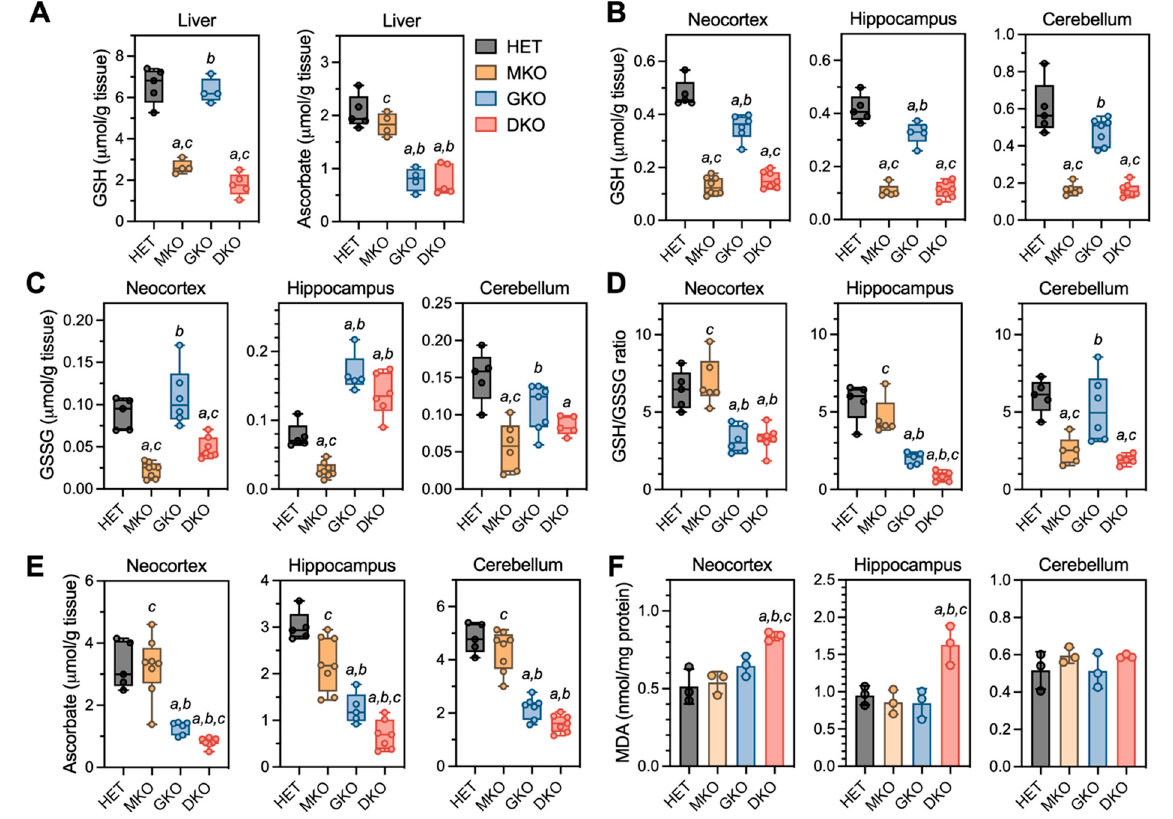
Figure 3. Redox biochemistry in liver and brain regions of young HET, MKO, GKO and DKO mice at PND18. ( A ), Liver tissues were processed for measurements of GSH and AA. Three brain regions were processed for measurements of ( B ), reduced GSH; ( C ), GSSG (oxidized GSH); ( D ), GSH/GSSG ratios (calculated from GSH and GSSG values of each individual animal); ( E ), AA; and ( F ), MDA (malondialdehyde is one of the final products of intracellular polyunsaturated fatty acids peroxidation). Data are expressed as means ± S.D. ( N = 4–5/genotype for livers and N = 5–8/genotype/region for brains). Group differences were analyzed by one-way ANOVA followed by Bonferroni post-hoc test. a p < 0.05, when compared to HET mice; b p < 0.05, when compared with MKO mice; c p < 0.05, when compared with GKO mice.